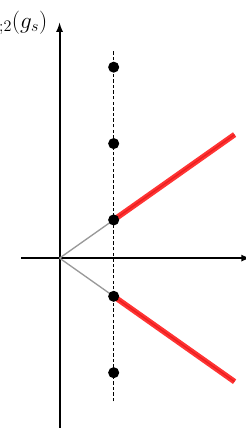
Figure 9: The singularities in the Borel plane for the series ϕ